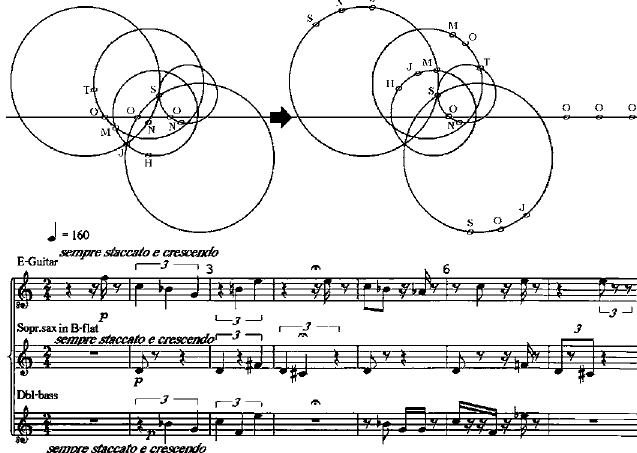
scalesFigure 15: The geometric derivation plan of Les Ciseaux de Tom Johnson and the first seven